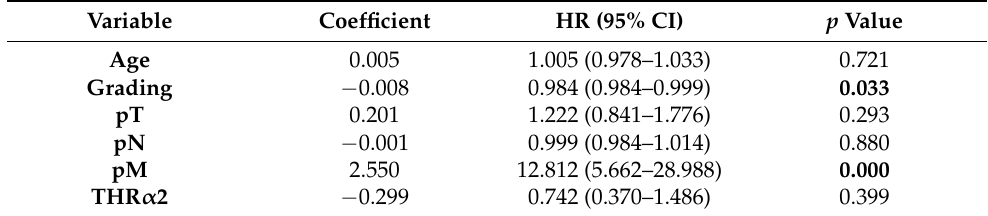
Table 3. Multivariate Cox regression analysis of multifocal and/or multicentric BC patients regard- ing DFS.